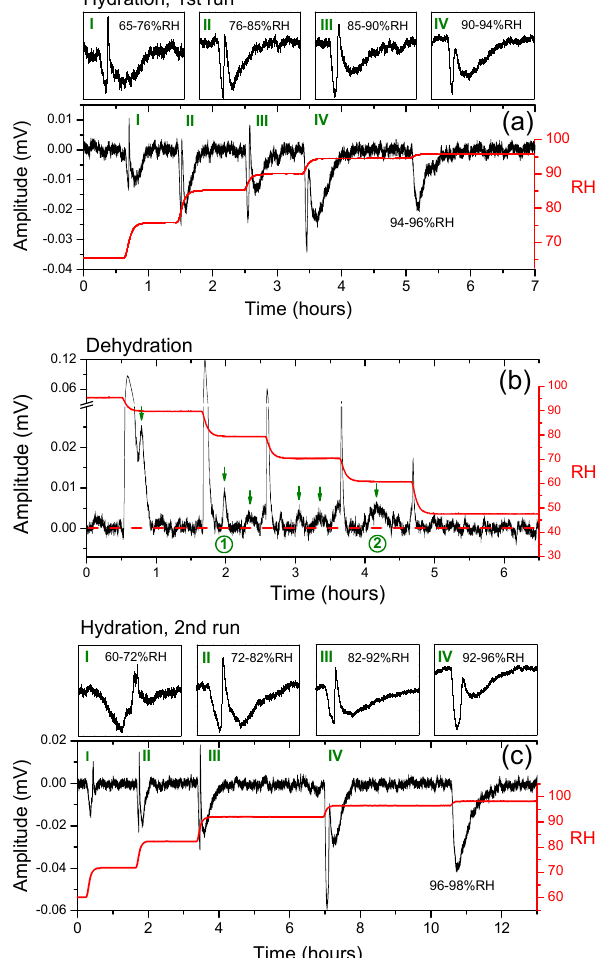
Figure 10. The water uptake diagram by the supermicron particles as a function of time during hydration (a, c) and dehydration (b) ex- periments. The red lines indicate the relative humidity (RH) change. The red dashed line in panel (b) helps to guide the eye to see the changing trend of background amplitude. Explanation of other sym- bols is given in the